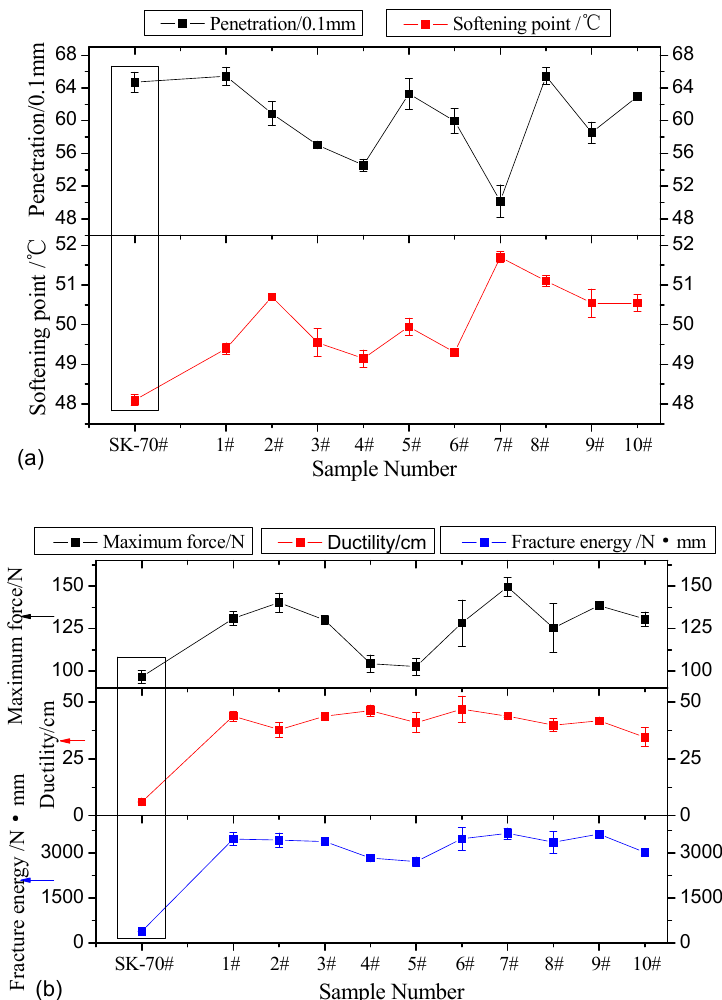
Figure 2. ( a , b ) Conventional asphalt performance index test results.